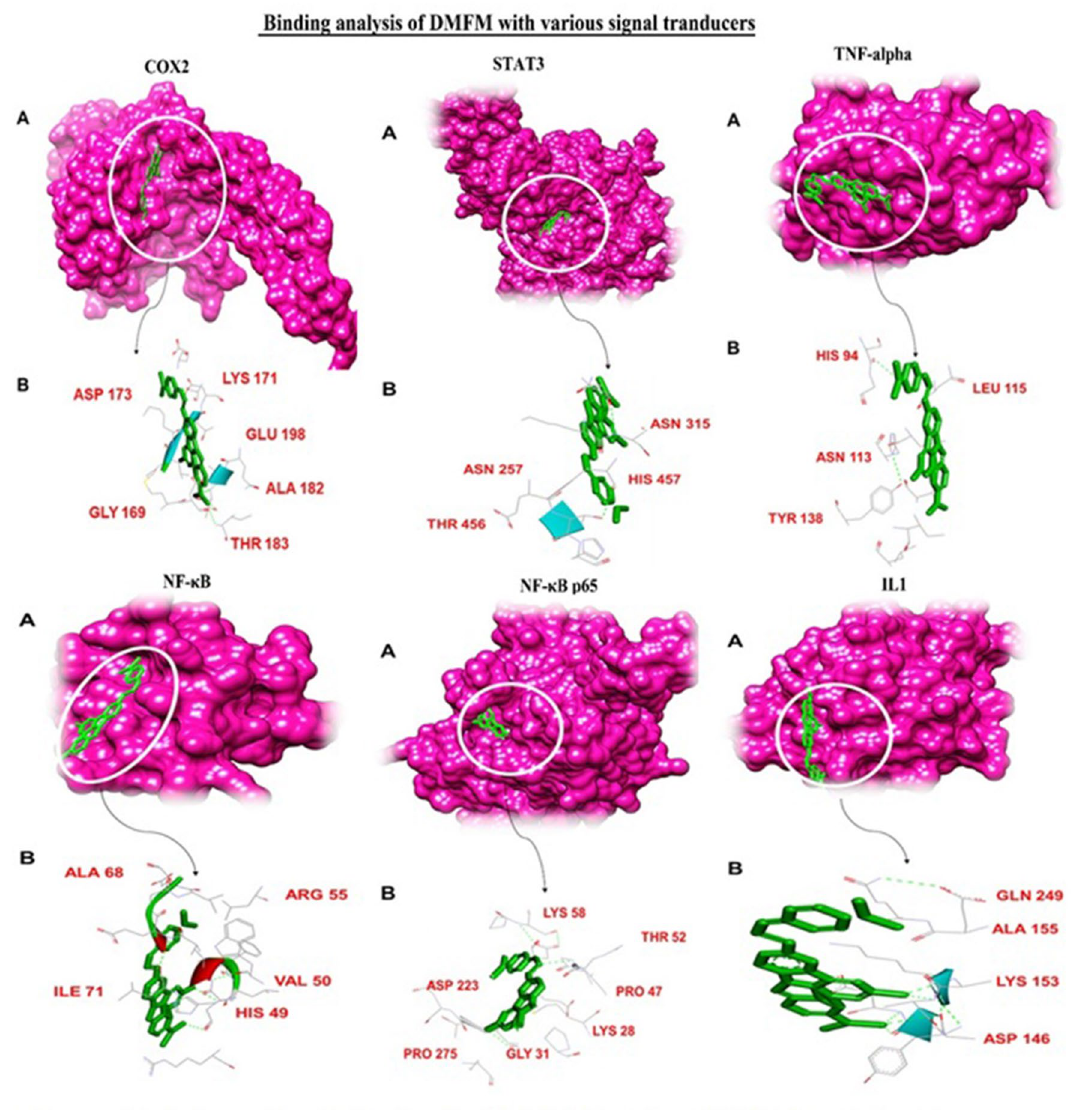
Figure 10. Binding analysis of DMFM with COX2, STAT3, TNF-α, NF-κB, NF-κB p65, and IL-1: ( A ) For each protein, a hydrophobic model is shown in purple color in 3D conformation while the docked DMFM compound is shown in green as a stick model. (B) In the 2D image, the DMFM compound is shown as a green stick model, and interacting residues of the protein are shown as grey sticks with H-bonding depicted as green dotted lines. Protein labels are indicated above each set of